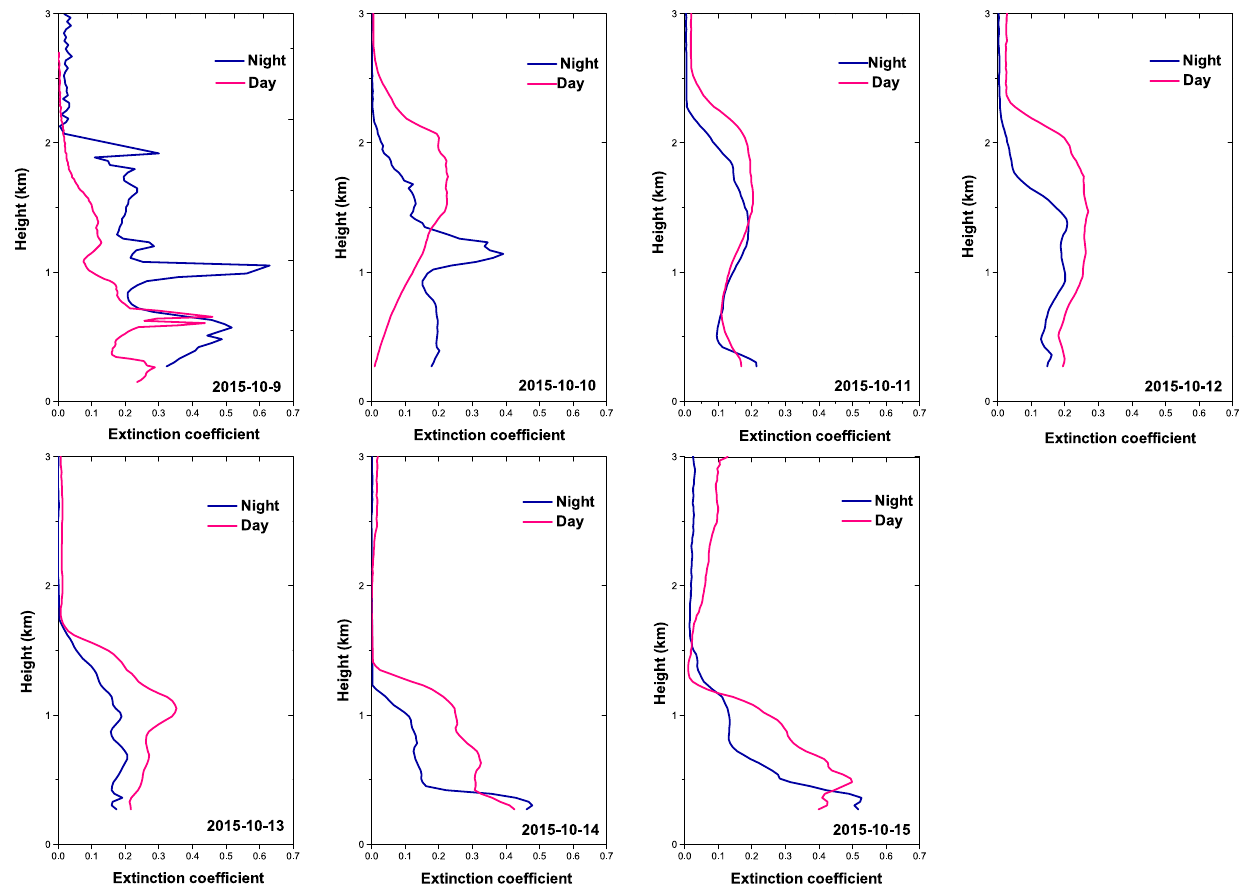
Figure 5. Profiles of the aerosol extinction coefficient from MPL-retrieved data, averaged for daytime and nighttime during 9–15 October 2015 in